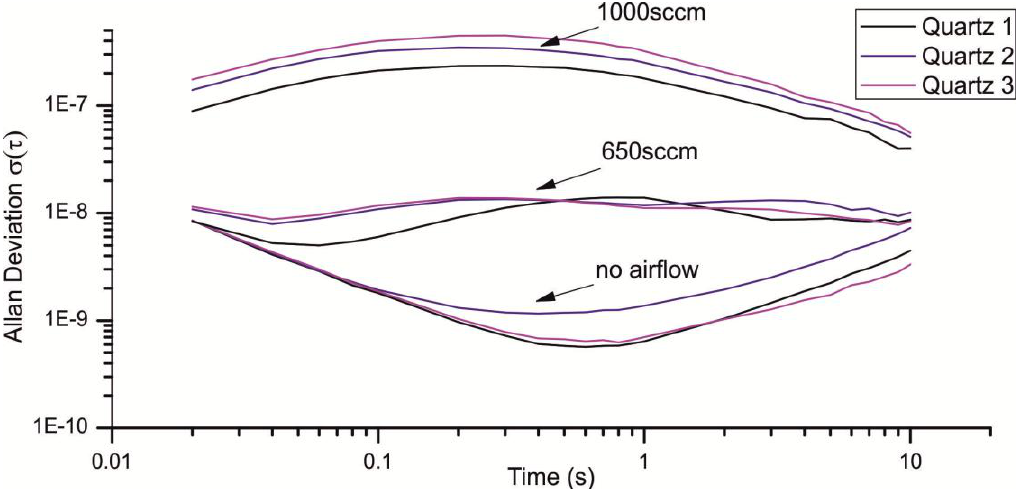
Figure 8. Allan deviation for different flow rates. The Allan deviation of 1,000 sccm and 650 sccm was measured at least 2 h after the device startup, whereas the Allan deviation without airflow was taken just after the